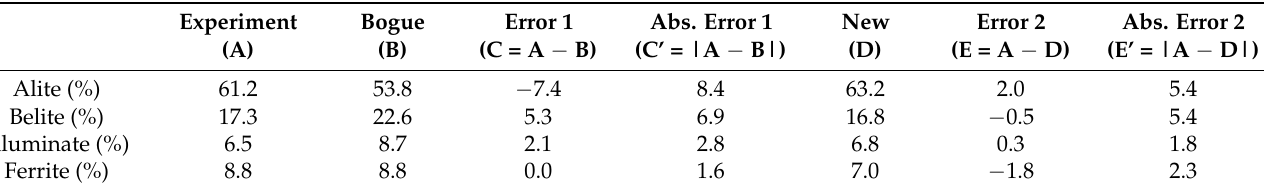
Table 12. The error percentage of the new and old models.